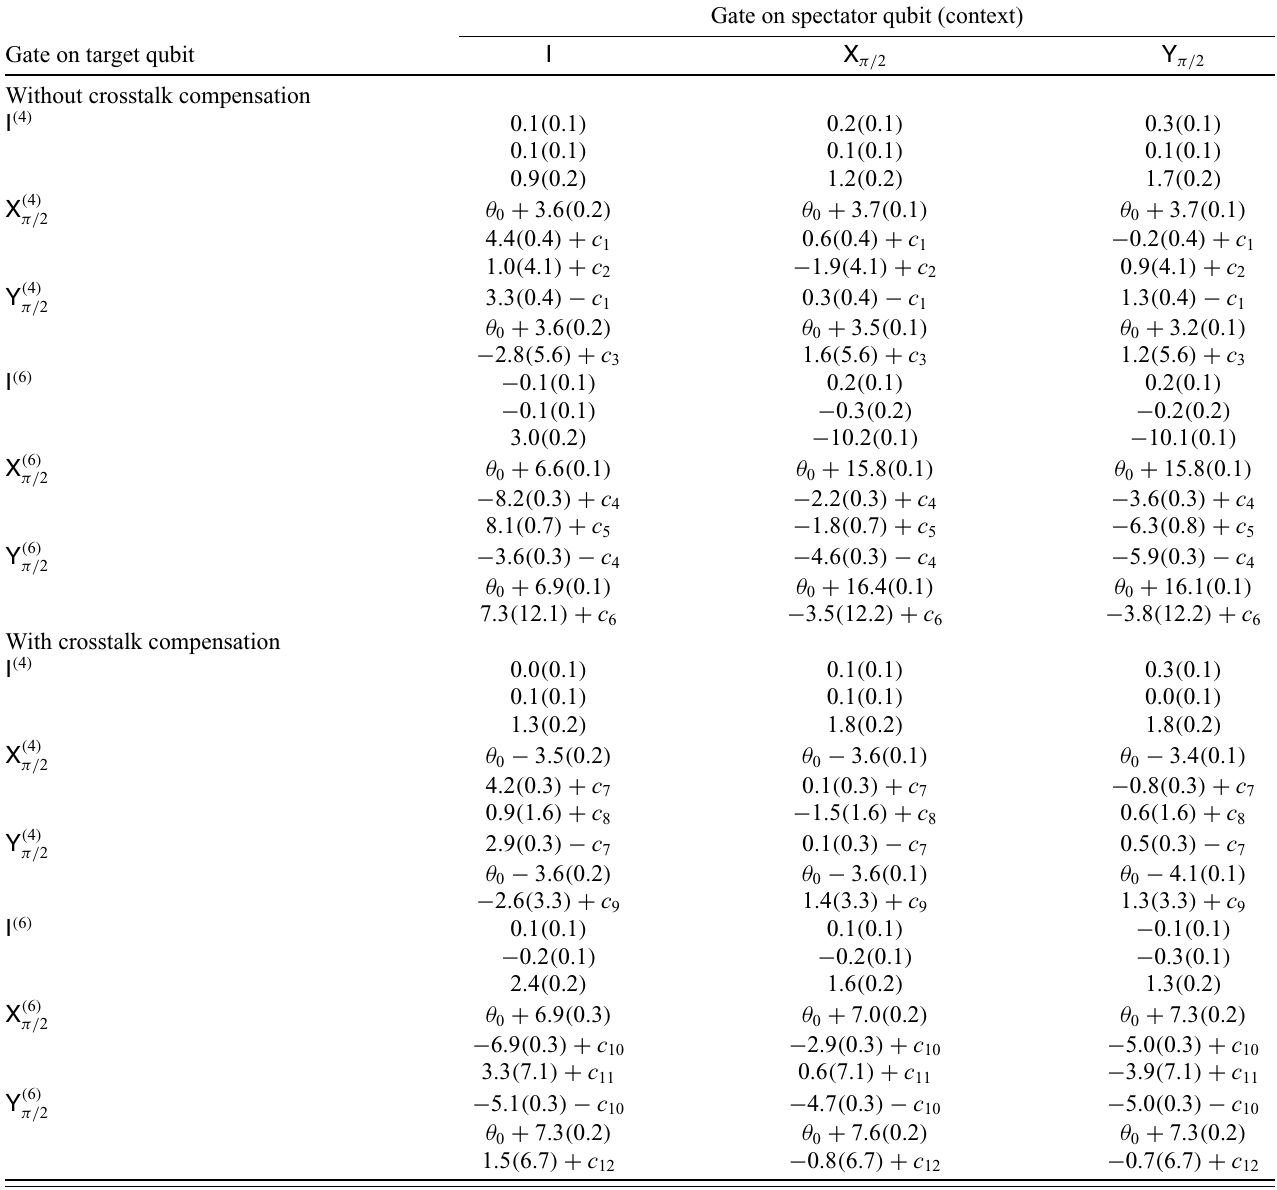
TABLE III. Estimated rates (in milliradians) of all Hamiltonian (unitary) errors, on all gates, in all contexts, for the context-dependent model of the AQT platform. Each column of three values is the three components unitary part of the estimated process (see the main text), represented as H eff = freedoms, which are reflected in this table by the unobservable constants c 1 , . . . , c 6 . Any value, or linear combination of values, containing no c ’s is gauge invariant, and therefore physically meaningful. All values have been shifted relative to the target value = π/ 4 rad (cid:15) 785.4 θ 0